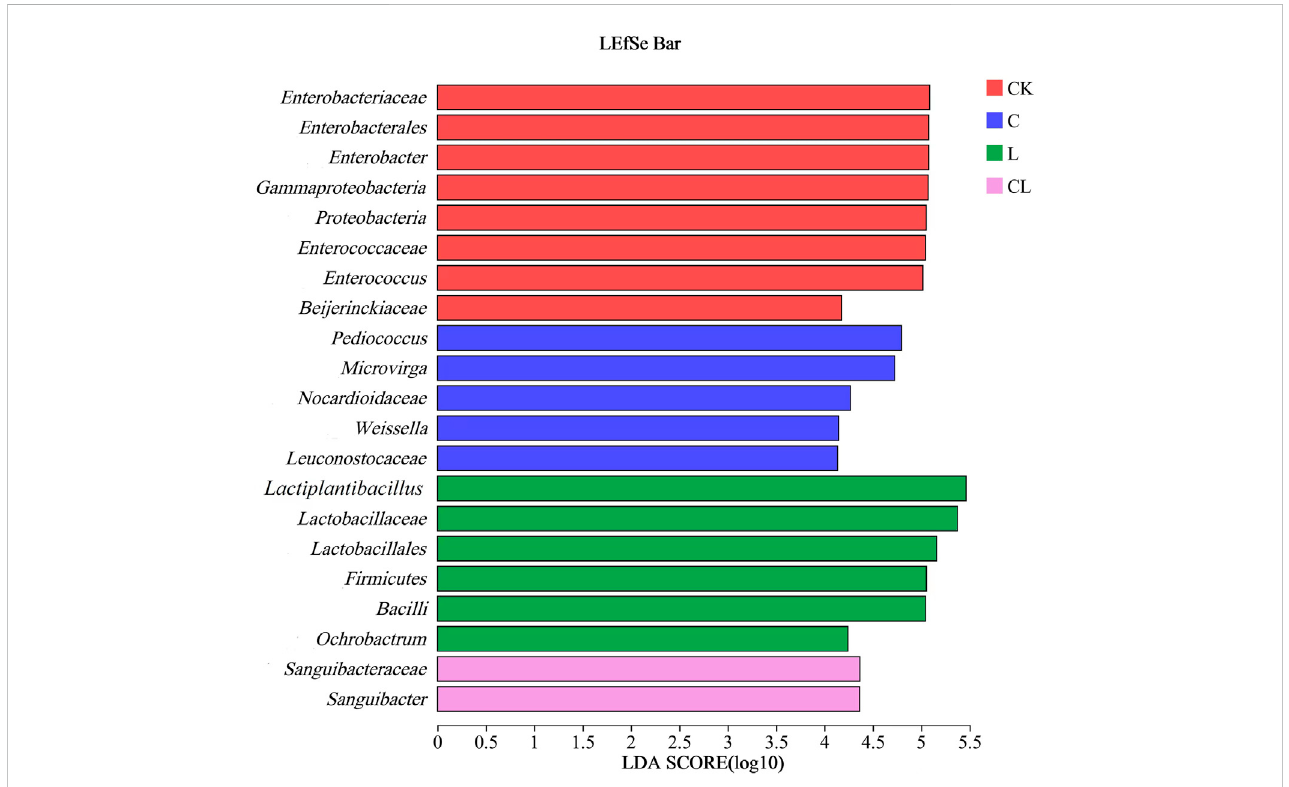
FIGURE 4 Discriminant analysis of LEfSe multilevel difference in Caragana korshinskii silage; CK, no additive; C, cellulase; L, Lactiplantibacillus plantarum ( L. plantarum ); and CL, cellulase + L. plantarum